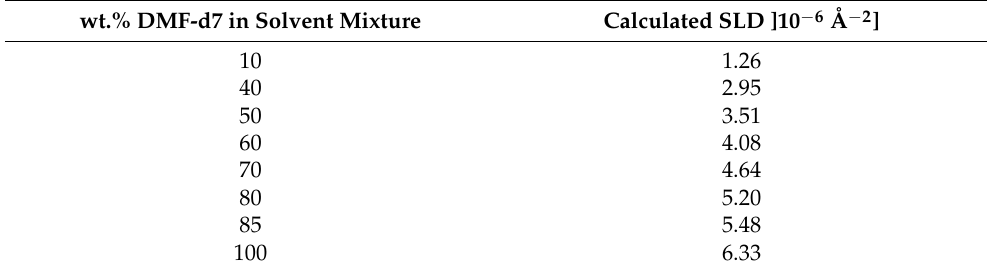
Table 4. SLD values for various DMF/DMF-d7 solvent mixtures used in this study. wt.% DMF-d7 in Solvent